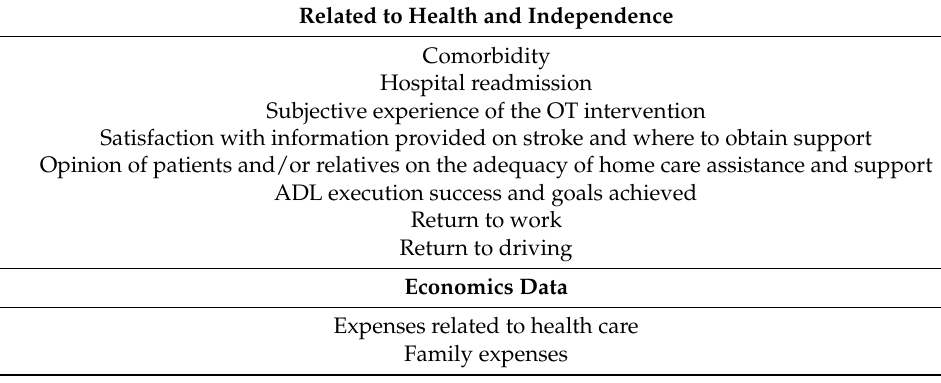
Table 2. List of other results and qualitative